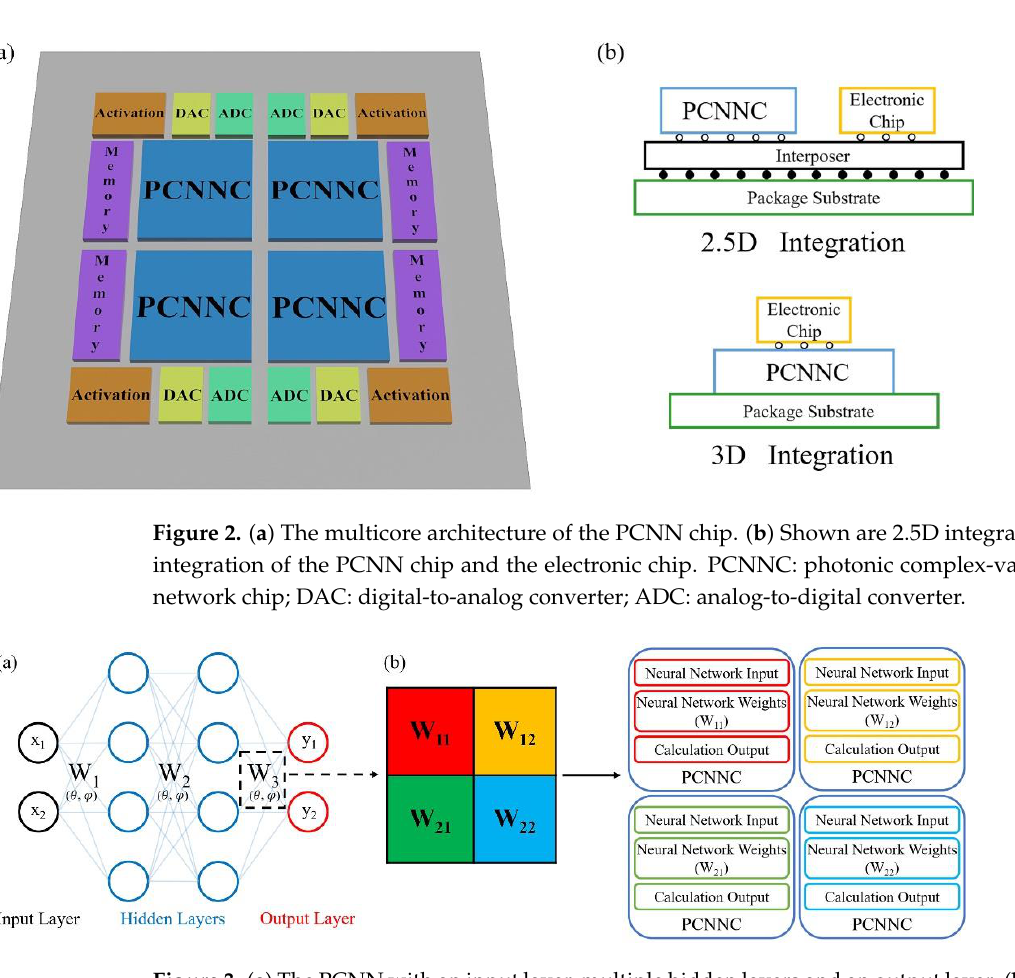
Figure 3. ( a ) The PCNN with an input layer, multiple hidden layers and an output layer. ( b ) Sche- matic diagram of multicore matrix calculation. PCNNC: photonic complex-valued neural network chip.